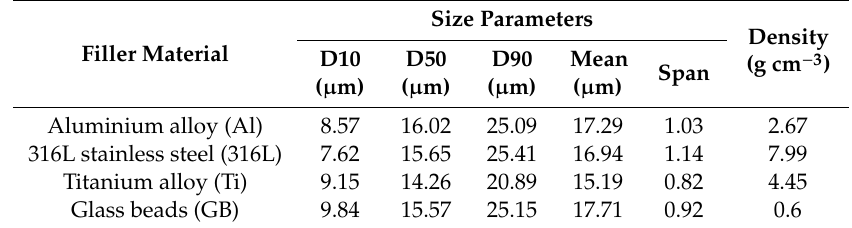
Table 2. Physical properties of filler materials.